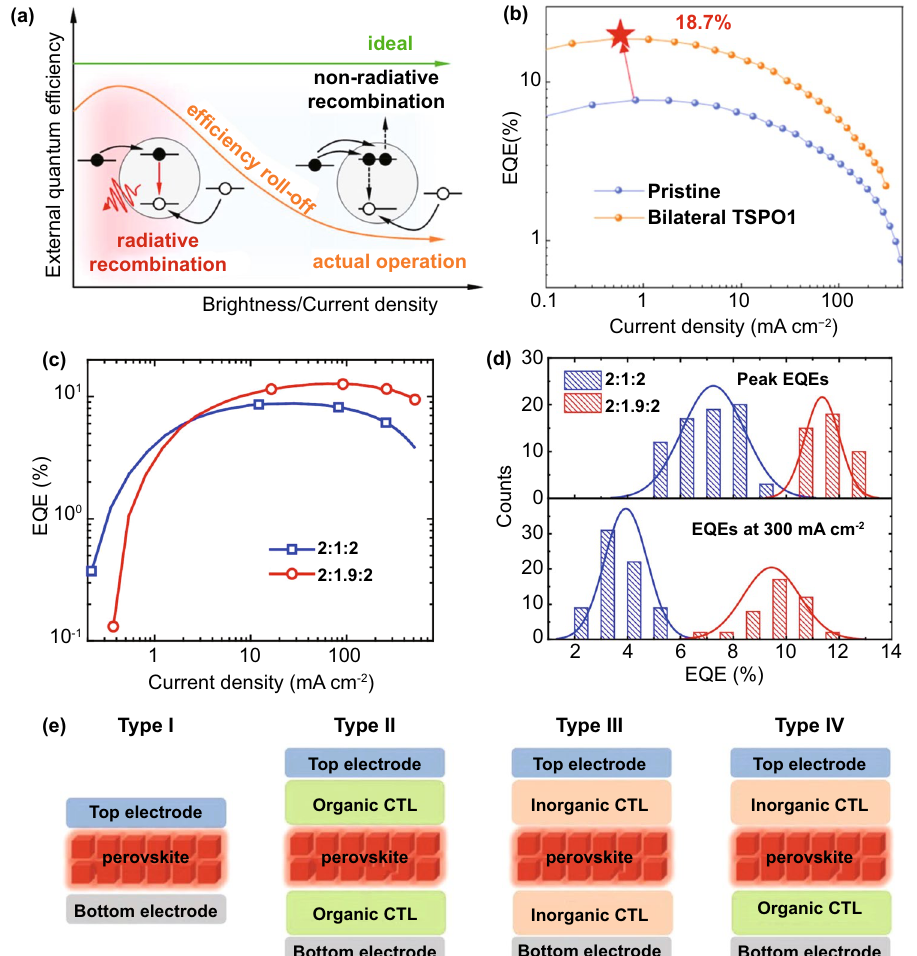
Fig. 6 a Efficiency roll-off under ideal and actual PeLEDs operating conditions. Copyright 2020 American Chemical Society [100]. b EQE of original and bilateral-passivated device. Copyright 2020 Springer Nature [87]. c EQE versus current density. d Histograms of peak EQEs and EQEs at 300 mA cm −2 . Copyright 2018 Springer Nature [91]. e Schematic diagrams of the four device structures of PeLEDs. Copyright